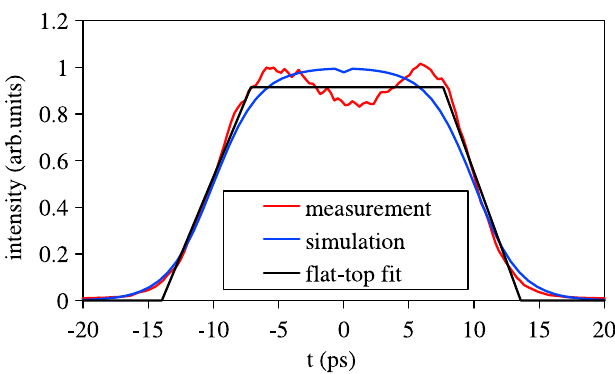
FIG. 8. (Color) Typical temporal profile (red) of a micropulse within a pulse train measured during the summer 2007 run with a synchroscan streak camera with 2 ps resolution. A flattop fit (black) is overlaid in the picture. The pulse duration (FWHM) is 23.8 ps, rise and fall times are about 7.2 ps and the variation in the flattop from peak to peak is (cid:1) 10% . The profile used as input to the beam dynamics simulations (discussed in Sec. III F 3) is shown in blue.